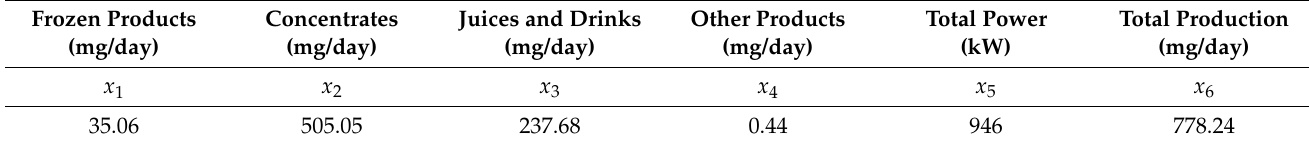
Table 7. Results of optimization by means of the genetic